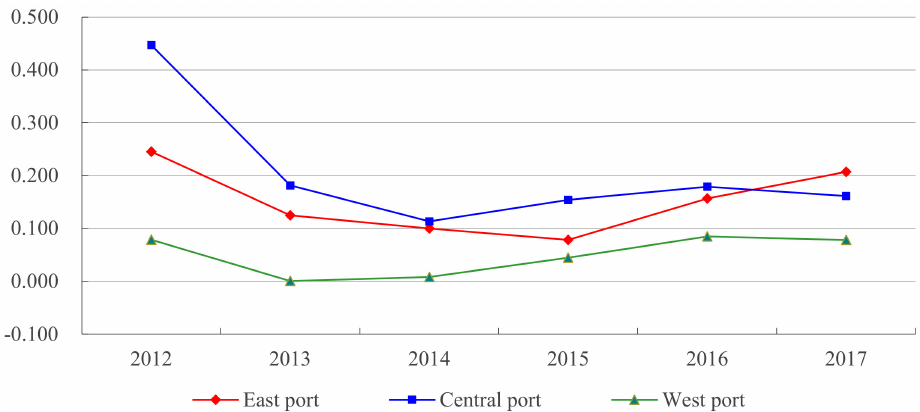
Figure 6. Variation trend of green TFP difference degree in eastern, central and western